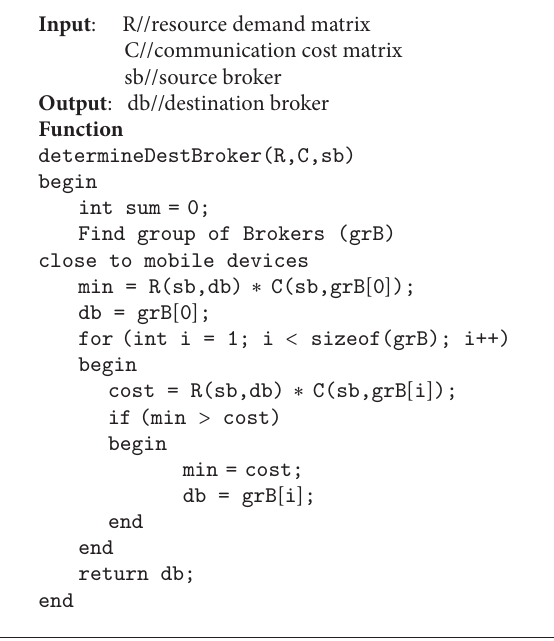
Algorithm 1: Determine the location of a destination